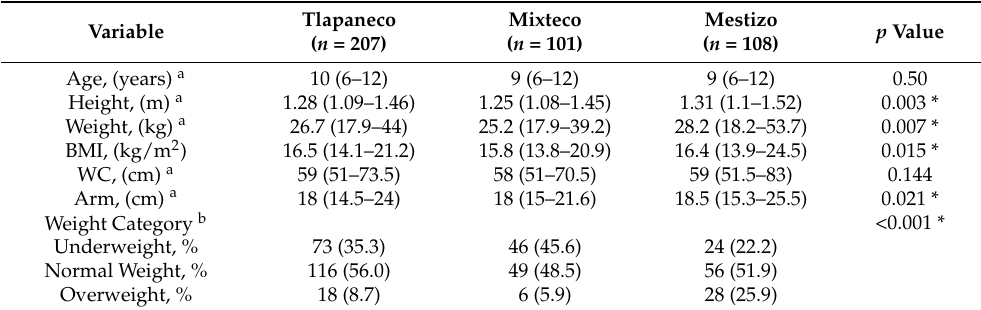
Table 1. Anthropometrical characteristics of the study sample according to ethnic